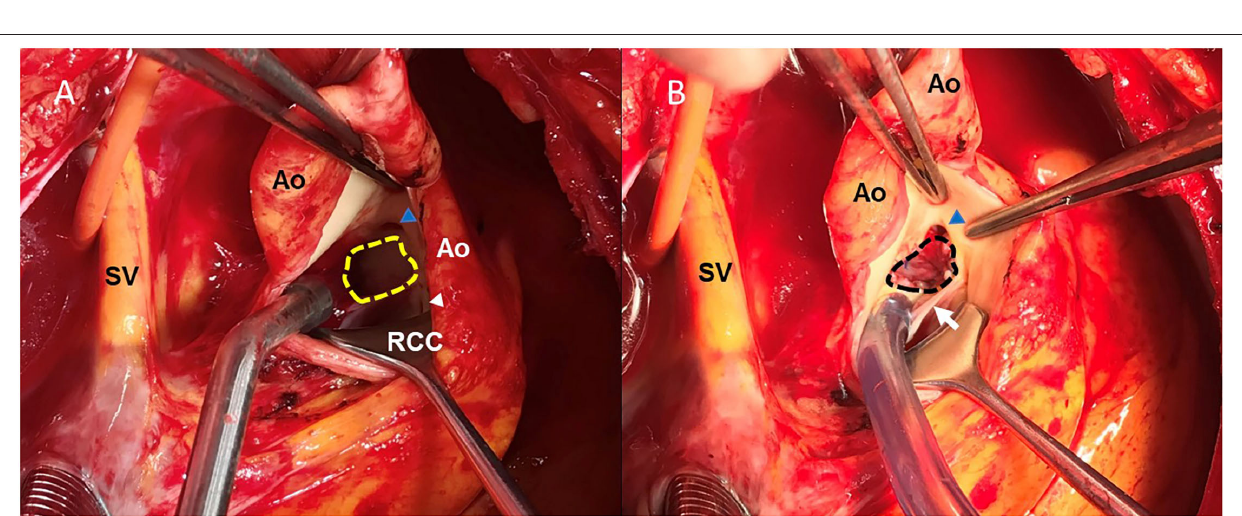
FIGURE 3 | The CAG showed the severely dilated left sinus of Valsalva and the contrast agent was preserved and rotated in a circle (A) . The aneurysm compressed the LMCA (yellow arrow) in the upward direction with significant LMCA seriously narrowing (B) . No critical stenosis was observed in LAD. Red stars, the outline of the SoVA; CAG, coronary artery angiography; LMCA, left main coronary artery; LAD, left anterior descending coronary artery, black arrow; white arrow, left circumflex coronary artery.